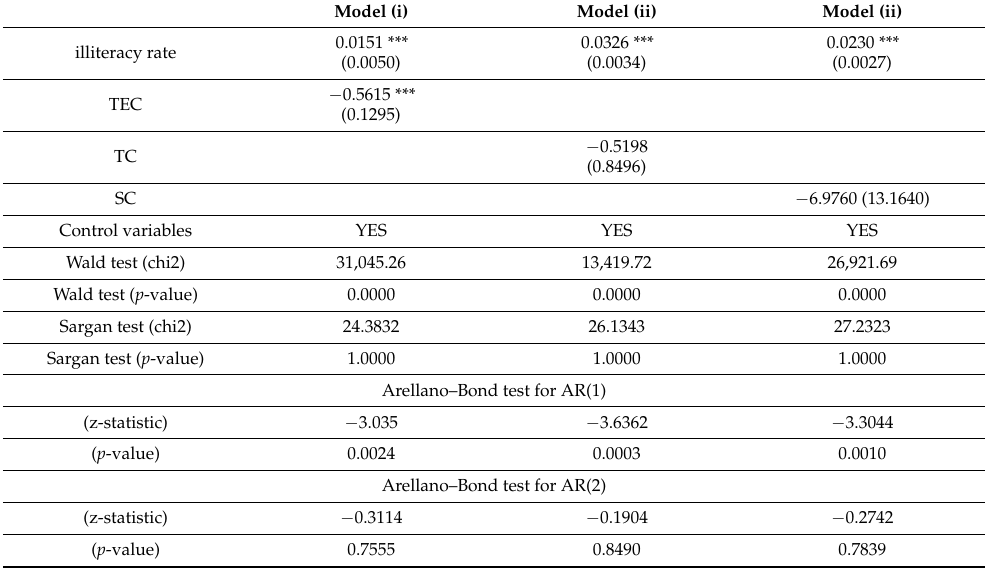
Table 6. The impact of the TFP change components on the rural–urban income